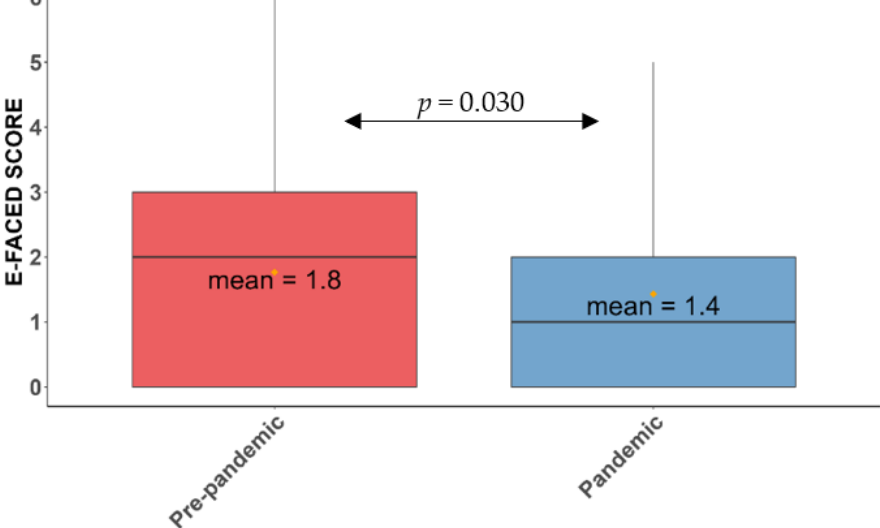
Figure 4. Mean score of the E-FACED scale in the pre-pandemic and pandemic periods. The yellow dots represent the mean of the E-FACED in the pre-pandemic (red) and pandemic (blue) periods.